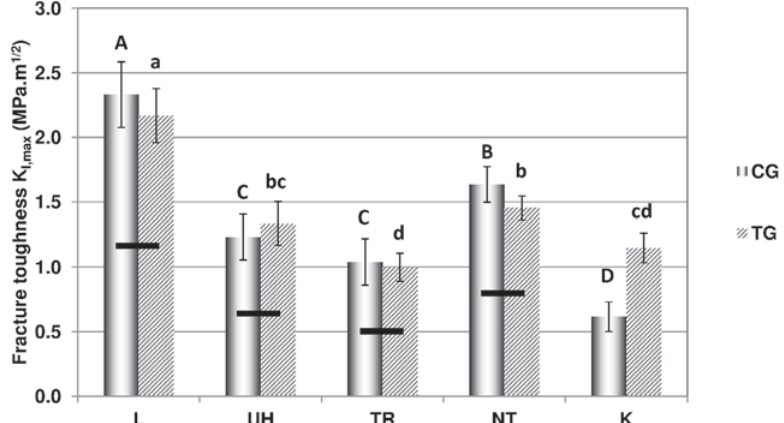
Figure 2- Means and standard deviations (SD) of fracture toughness KI,max (MPa.m 1/2 ) for the materials and